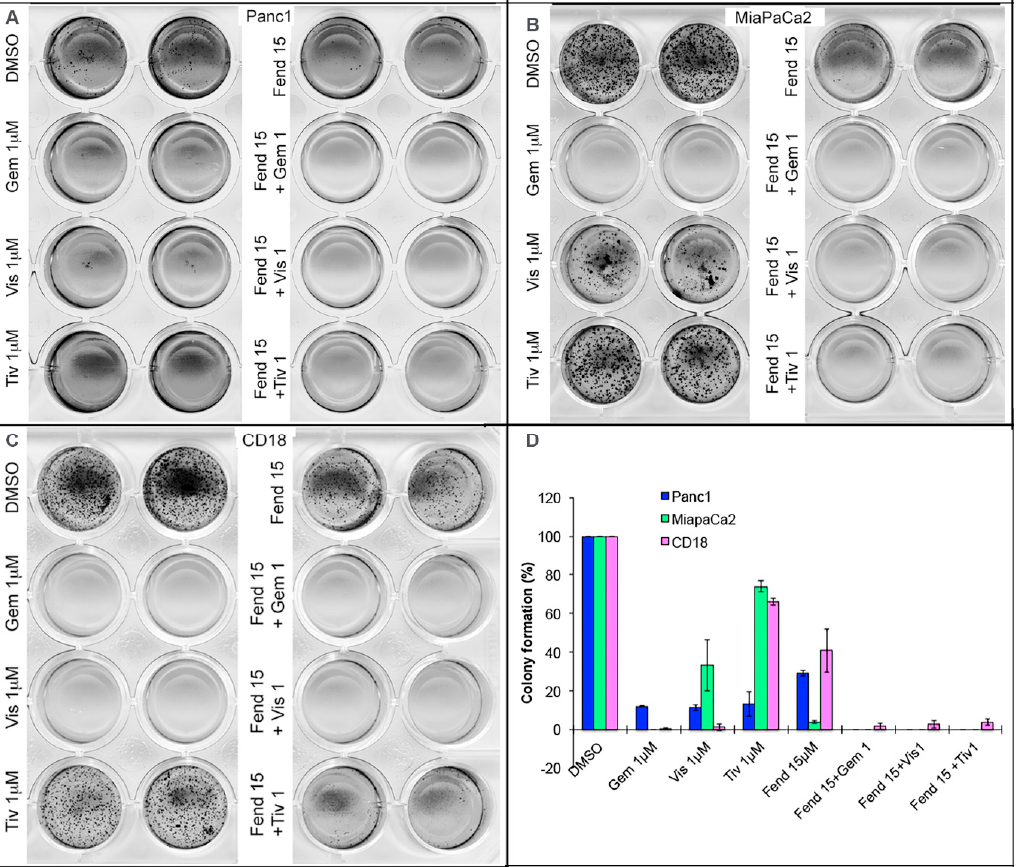
Figure 4. Anchorage independent growth of PDAC cells is inhibited by combinatorial treatment with fendiline: 2500 Panc1 ( A ), MiaPaCa2 ( B ) or CD18 ( C ) cells were allowed to form colonies on soft agar,